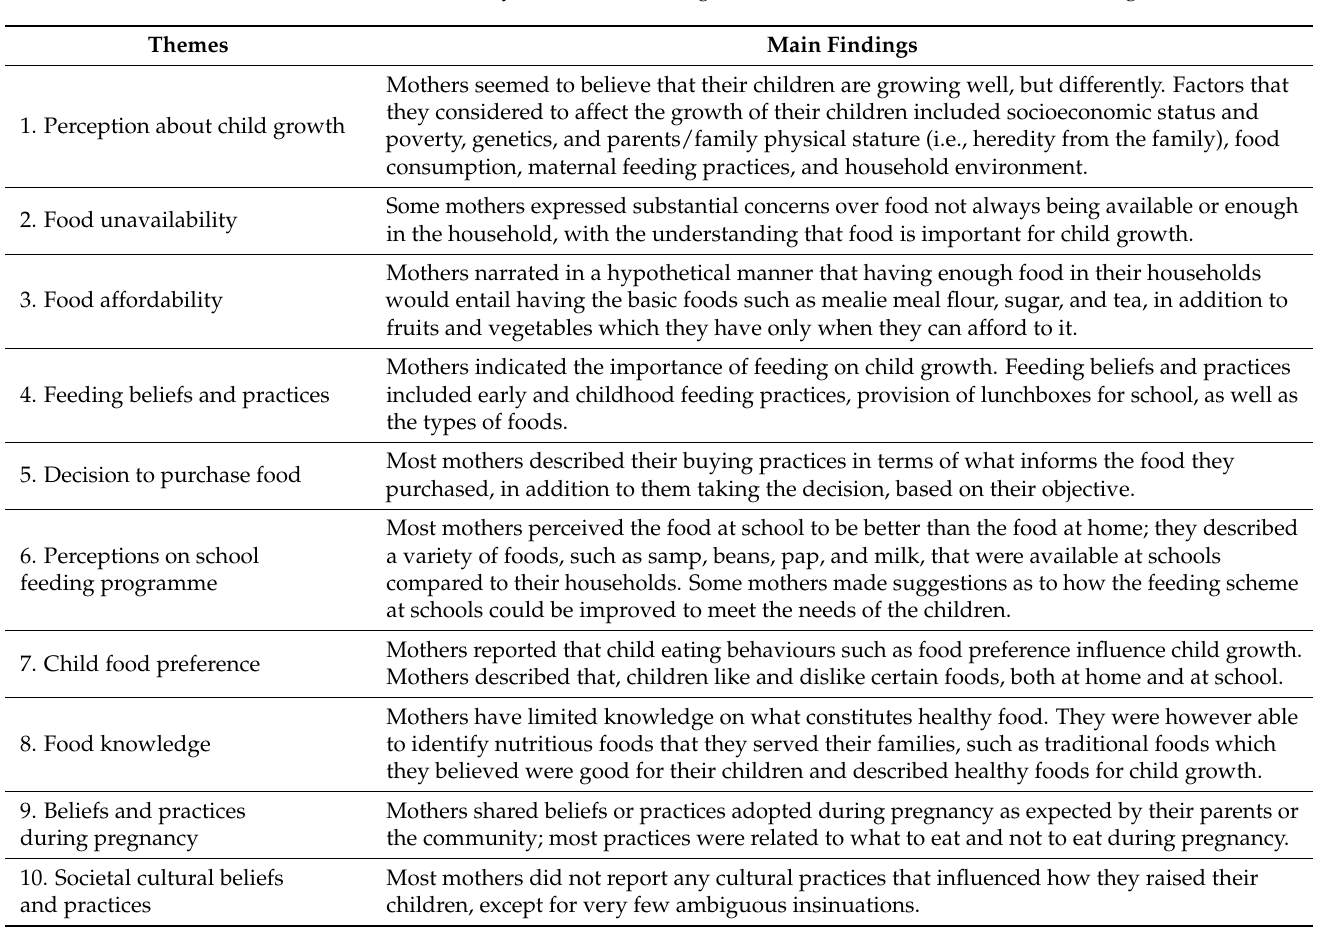
Table 2. Summary of the main findings of the FGDs with mothers with ten emerged themes.